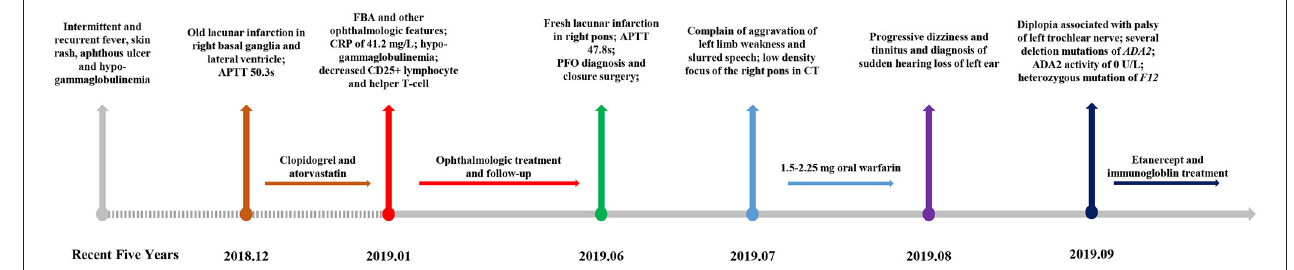
FIGURE 3 | Time-line of main events of the